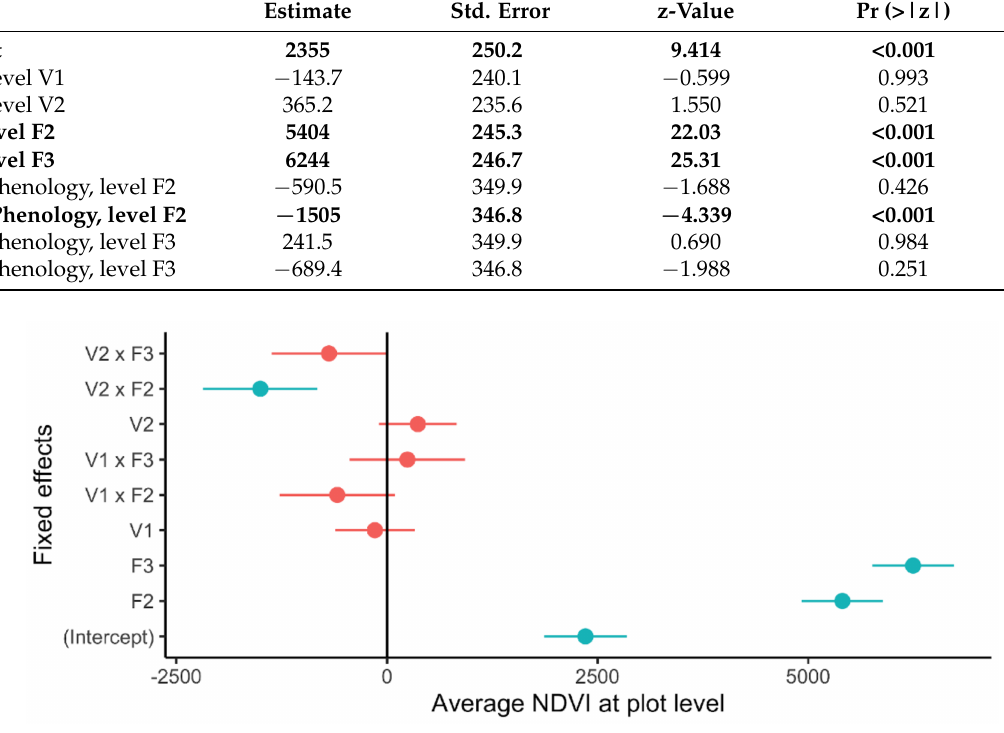
Figure 6. Model 2, coefficients and confidence intervals of fixed effects (NDVI optimal model